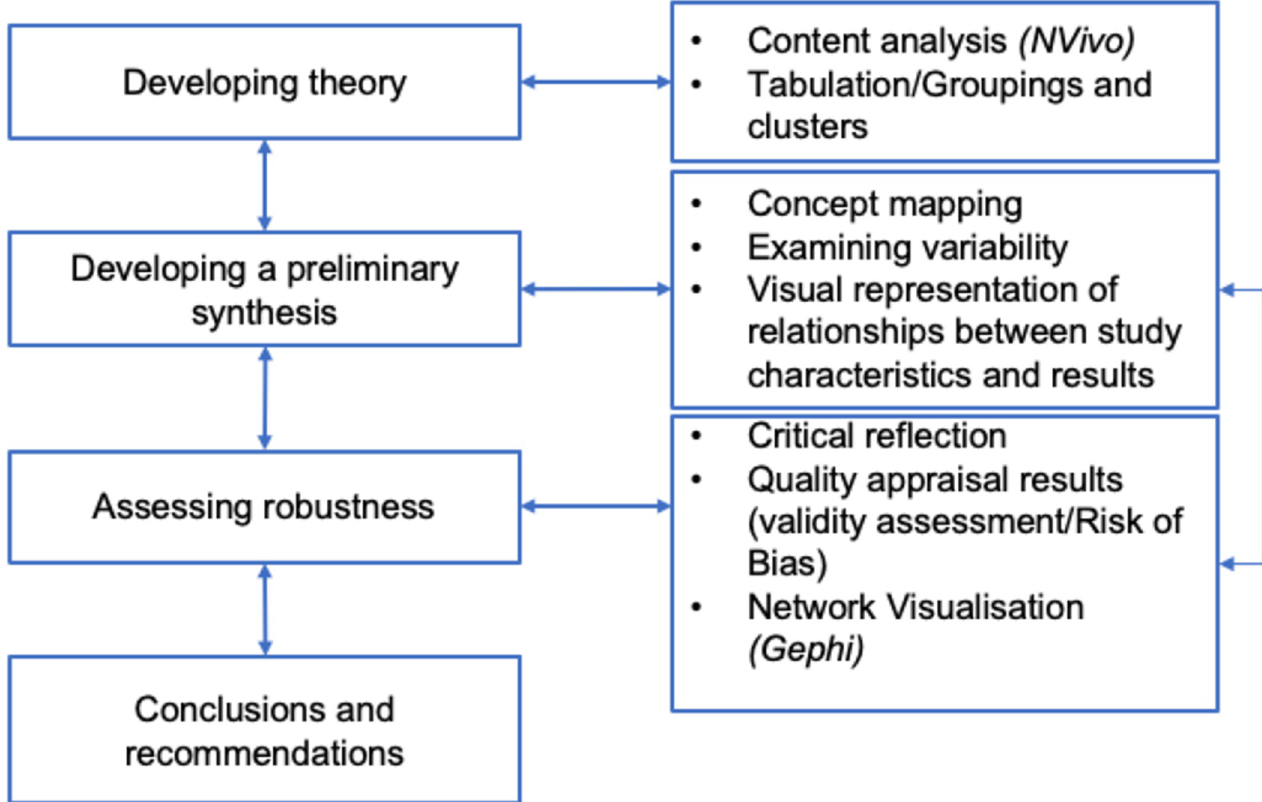
Fig 3. Integrative narrative synthesis process. The Figure details the integrative narrative synthesis process applied during the review (adapted from Popay et al., 2006).